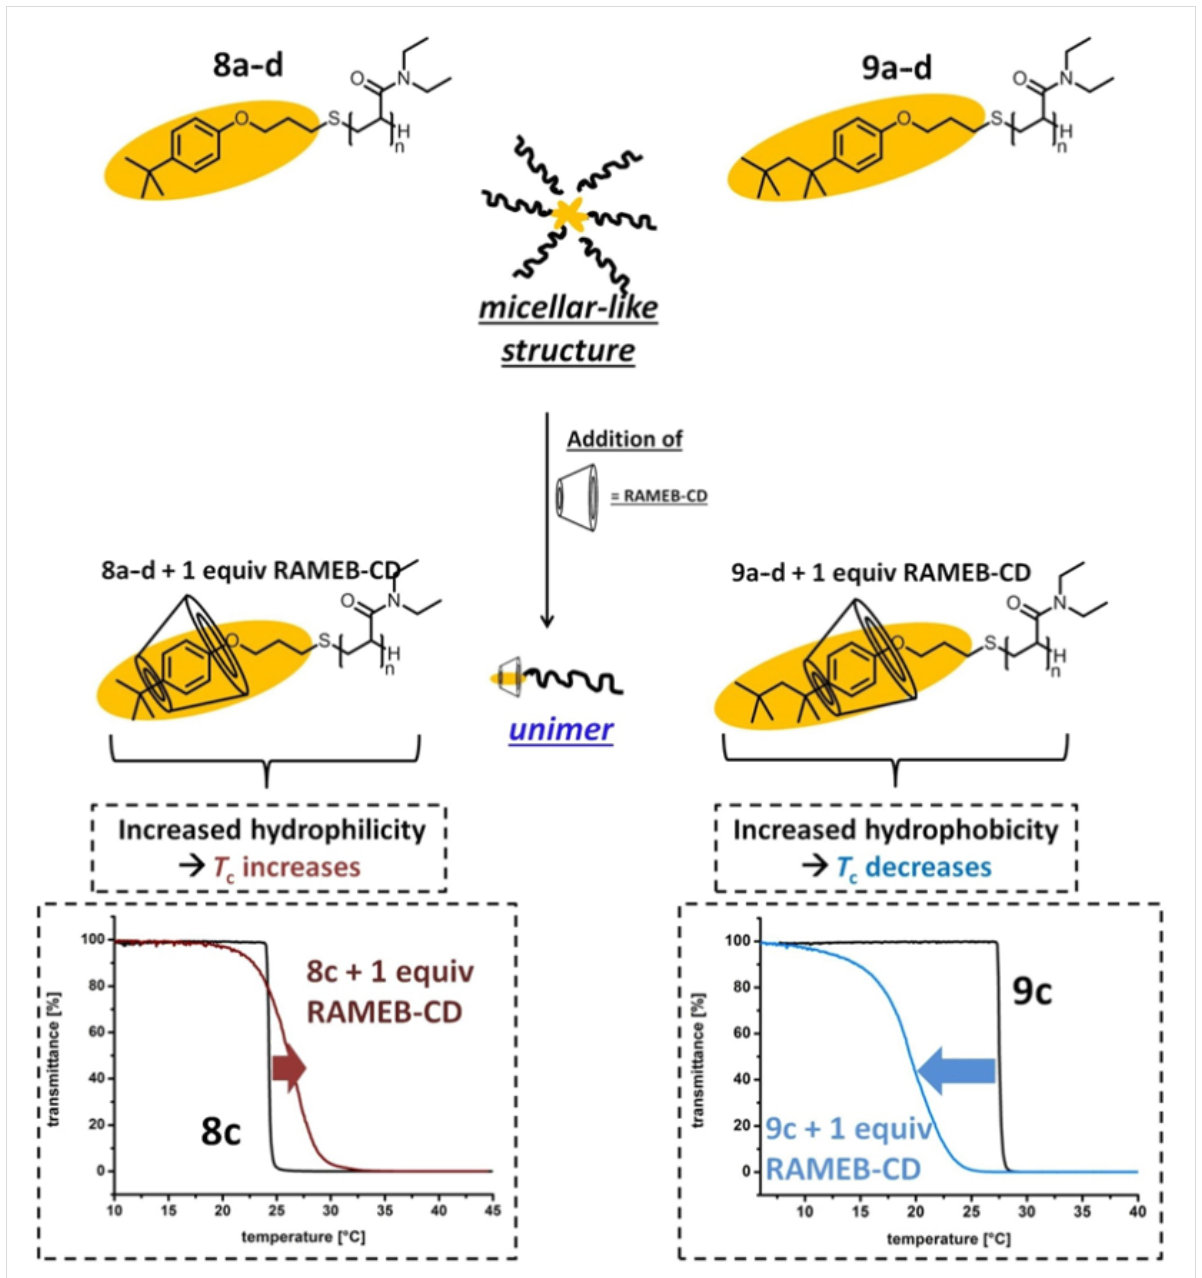
Figure 9: Schematic illustration of the micellar-like structures, its deformation upon addition of one equivalent RAMEB-CD and the influence on the cloud point values determined by turbitidy measurements on aqueous solutions (concentration: 10